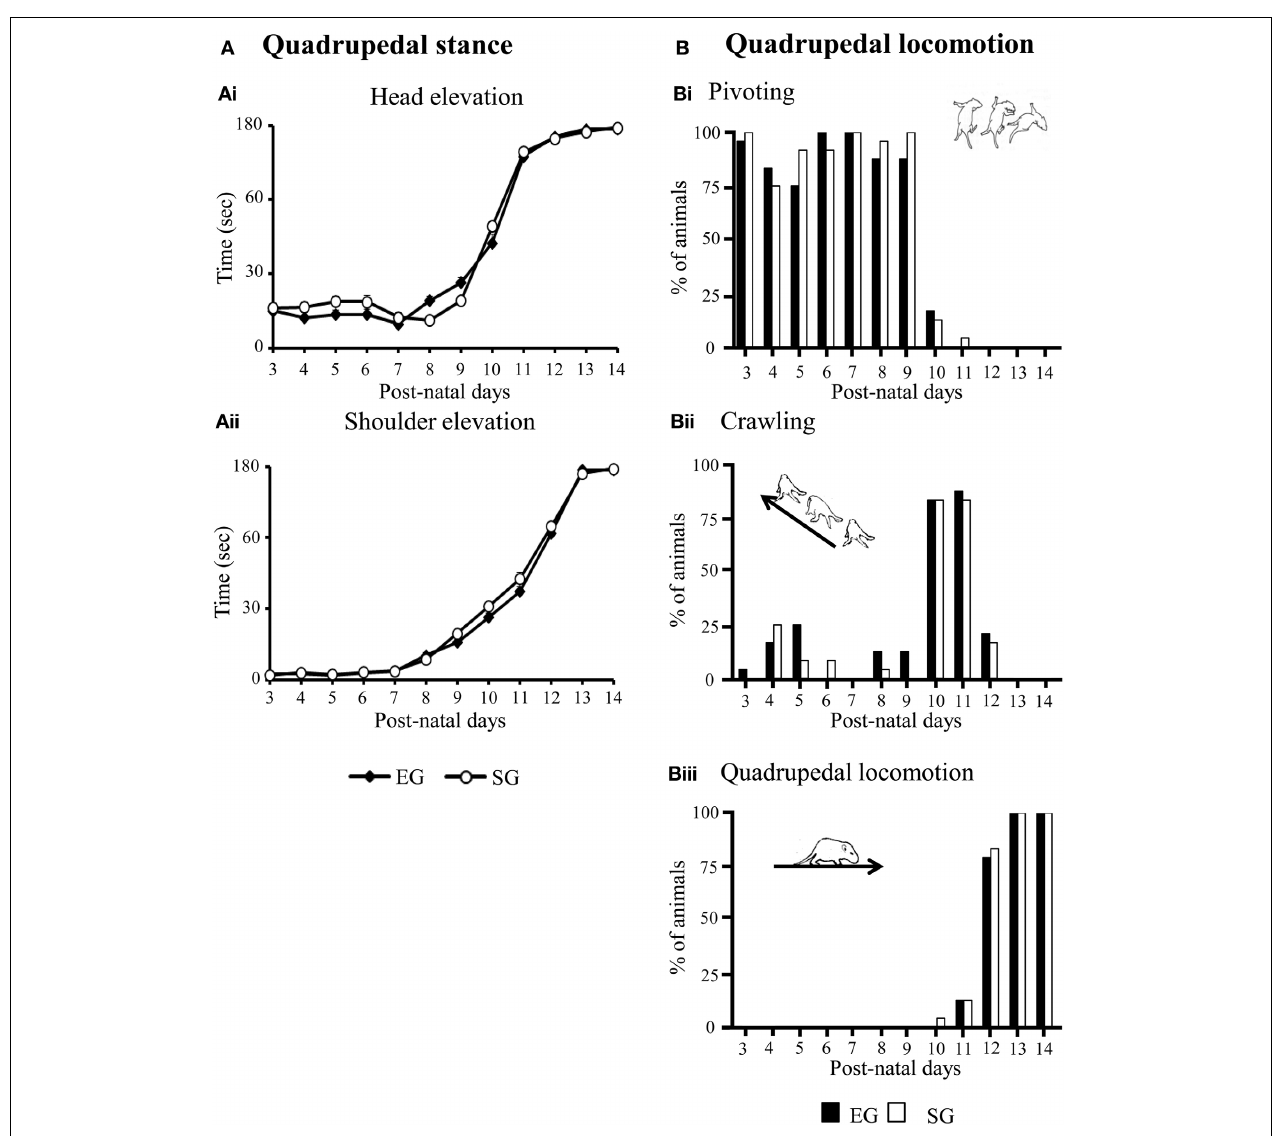
FIGURE 4 | Results of pre-reproductive maternal rearing condition on development of quadrupedal stance (A) and locomotion (B). Line graphs indicateelevationtimeofhead (Ai) andshoulders (Aii) .Resultsarereportedas